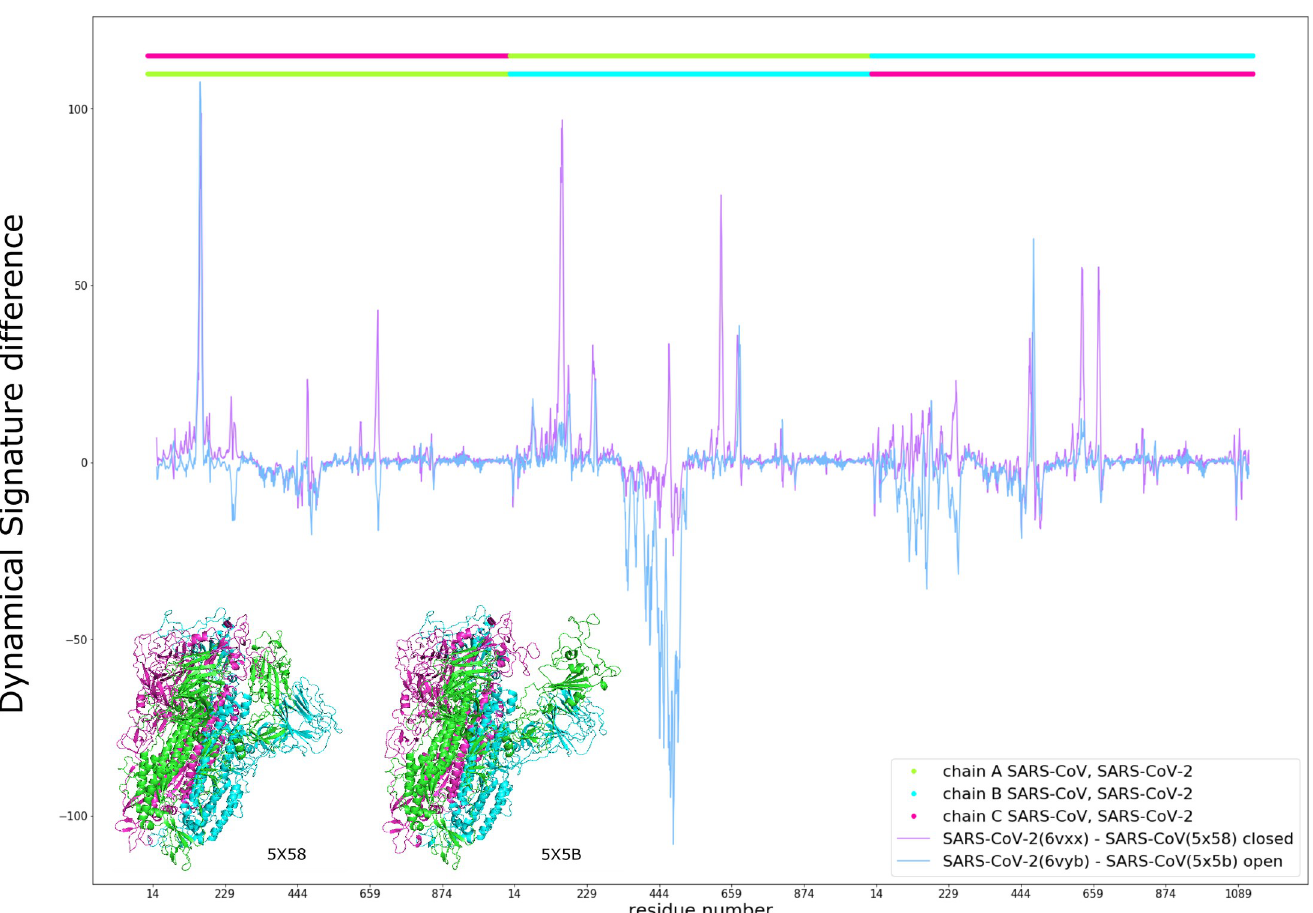
Fig 5. Comparison between SARS-CoV-2 and SARS-CoV. Dynamical Signature difference of the closed (purple) and open B chain RBD (blue) between aligned residues of the Spike protein from SARS-CoV-2 and SARS-CoV, with SARS-CoV chains represented in the top bar and equivalent colors in the structures and SARS-CoV-2 chains represented in the bar just